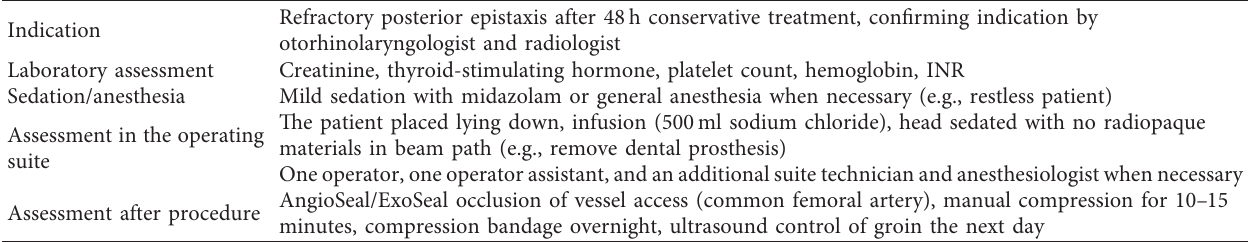
Table 1: Patient assessment before and after intervention.